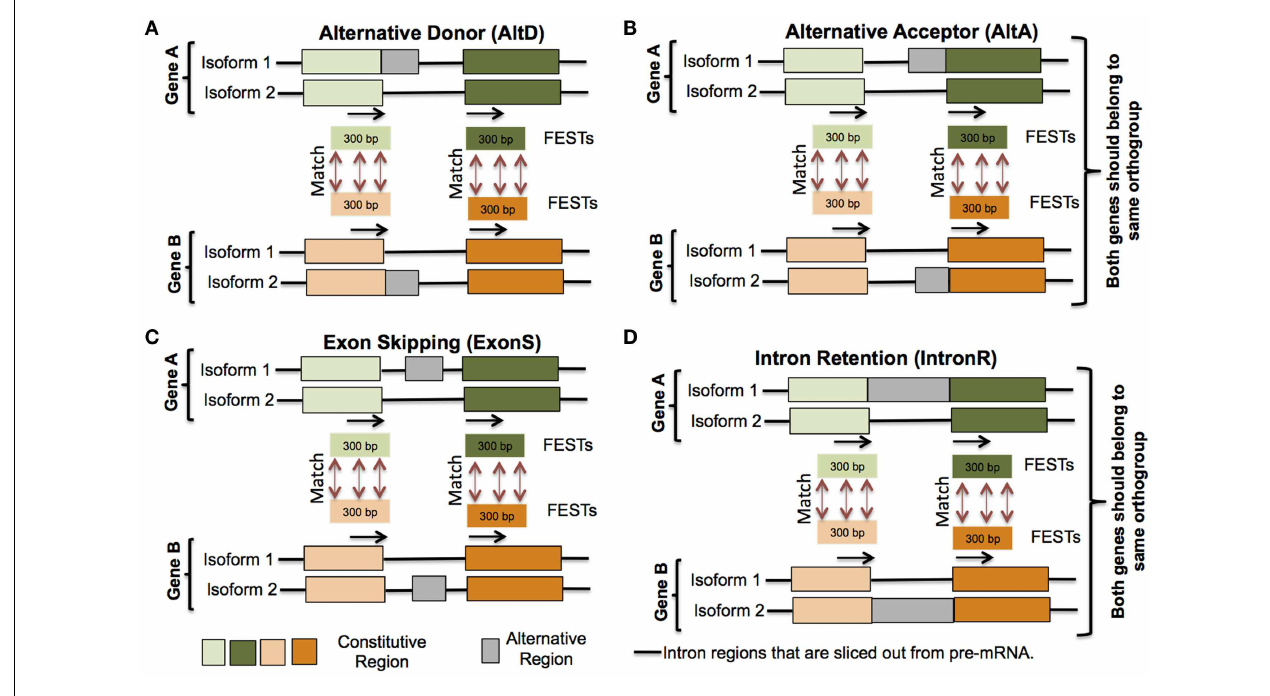
skipping and (D) Intron retention, (iii) Use BLAST to align FESTs to their corresponding event data sets, and (iv) AS events between two genes are classified as conserved, if each gene’s FESTs exhibit same AS type and also their FESTs